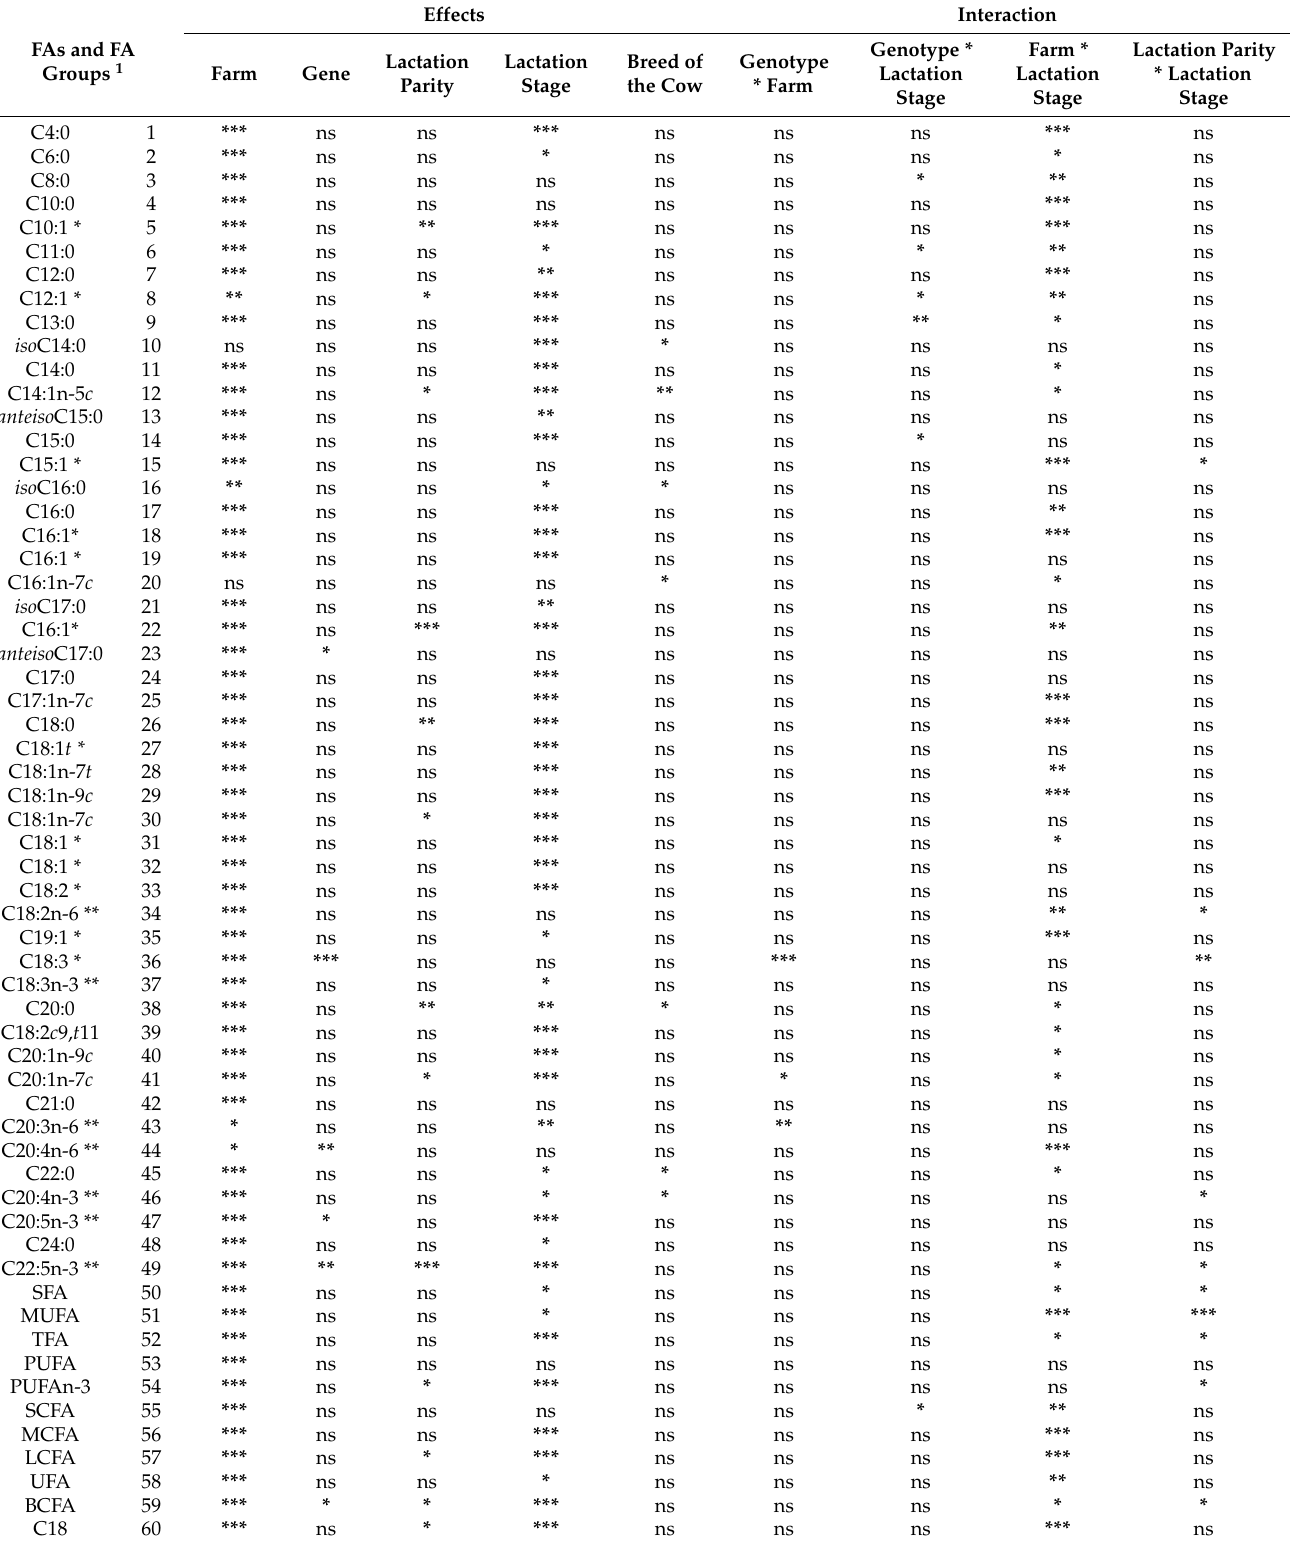
Table 6. Effects on the fatty acid (FA) proportions ( p- values)— LEP